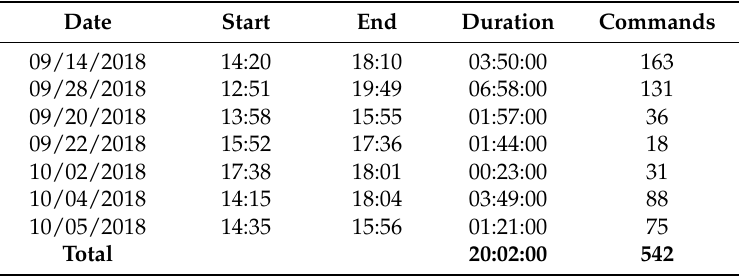
Table 1. Summary of system usage